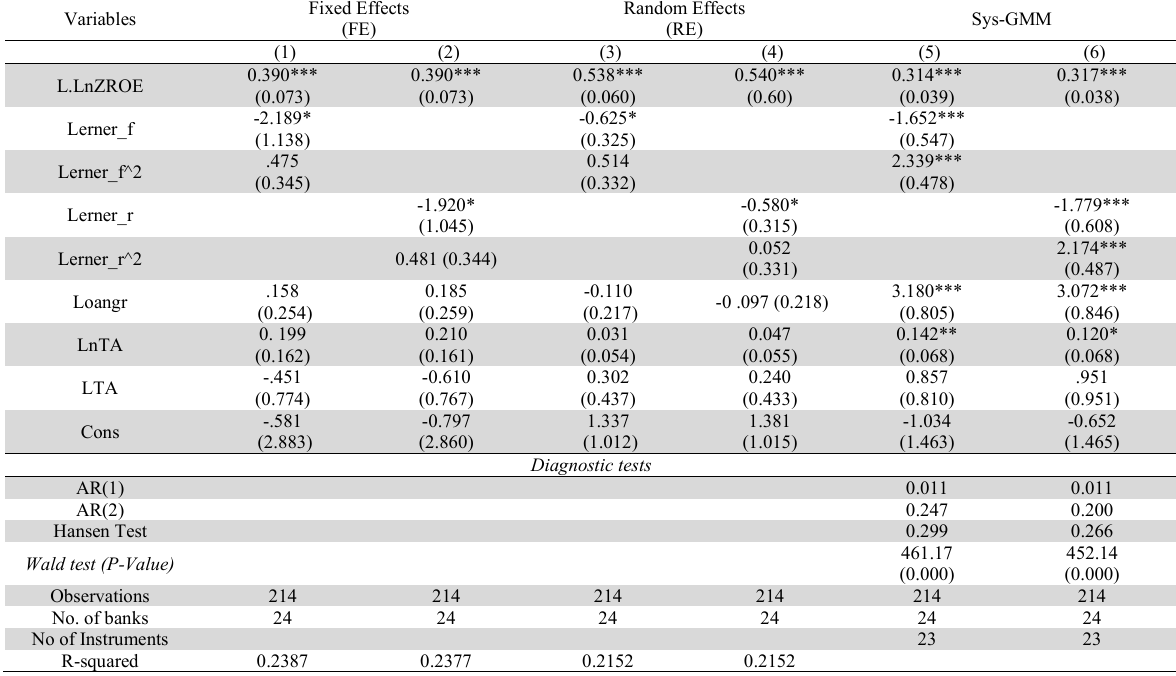
Estimation results for LnZROE as dependent